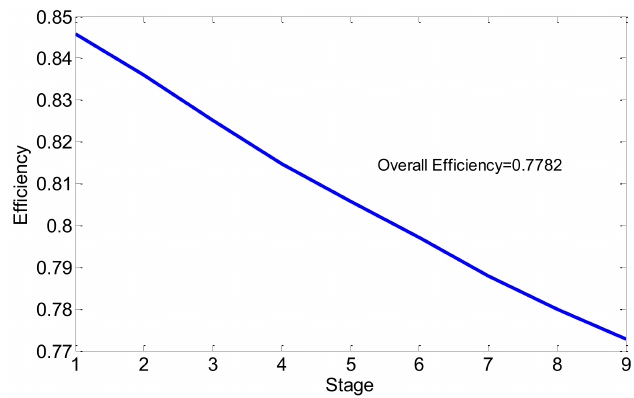
Figure 9. Variation of each stage’s